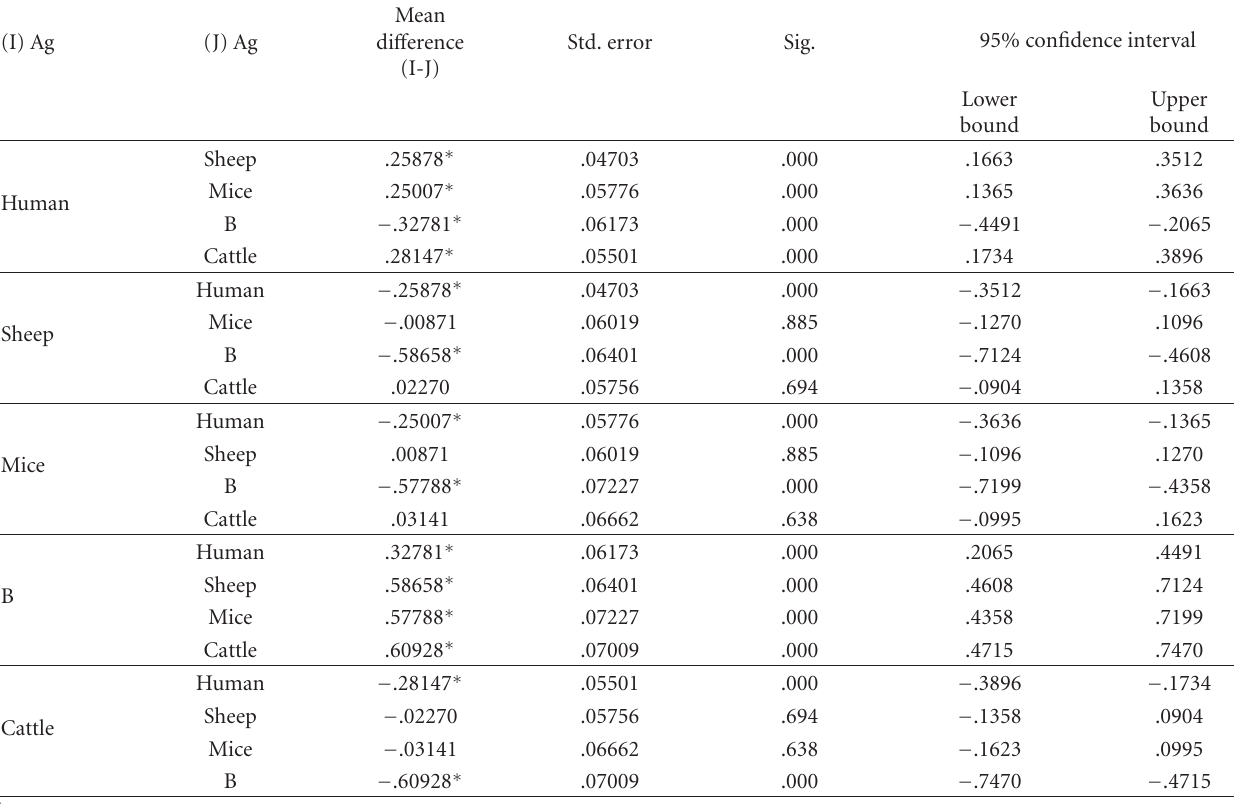
Table 9: Multivariate analysis of di ff erent HCF antigens based on mean OD values of human total IgG responses using post hoc analysis.